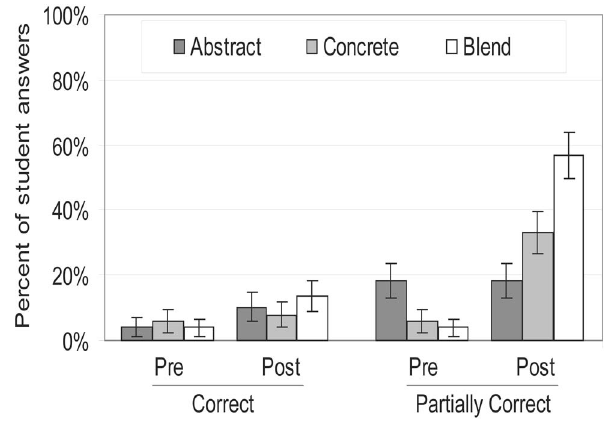
FIG. 7. Fraction of correct (cid:1) P=Q=R=S (cid:2) and partially correct (cid:1) P=Q=R (cid:1) S (cid:2) answers on pre-post question 2 from the across do- main